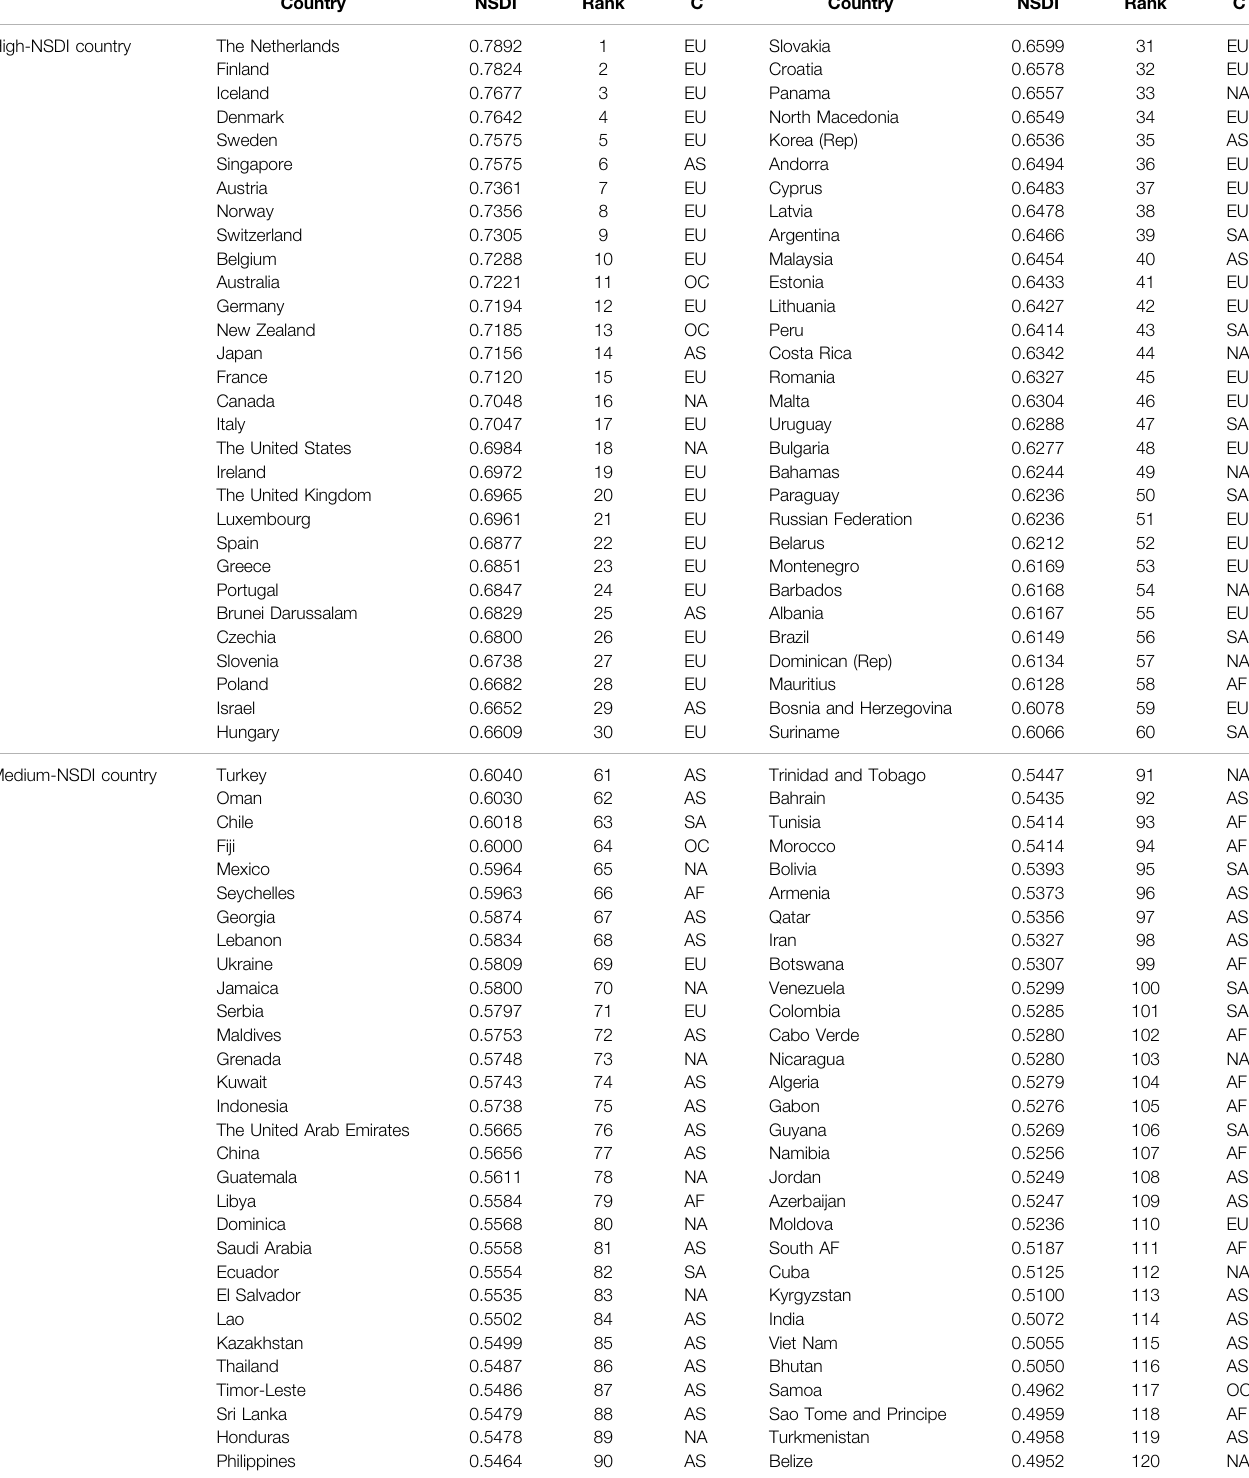
TABLE 3 | The mean value of NSDI and its ranking of 179 countries from 2010 to